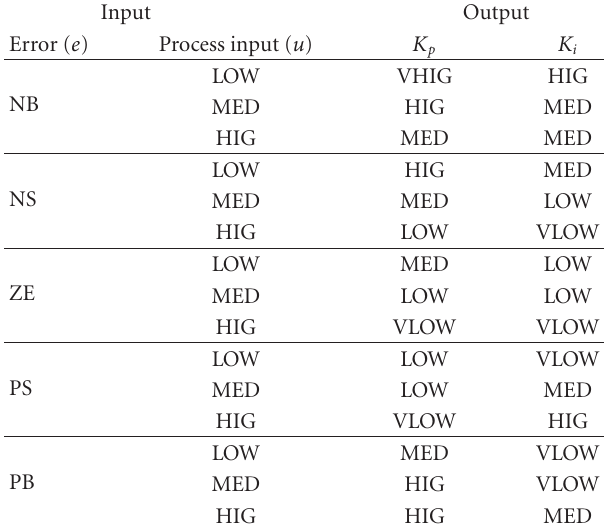
Table 2: Rule base for fuzzy-coordinated PI controller.